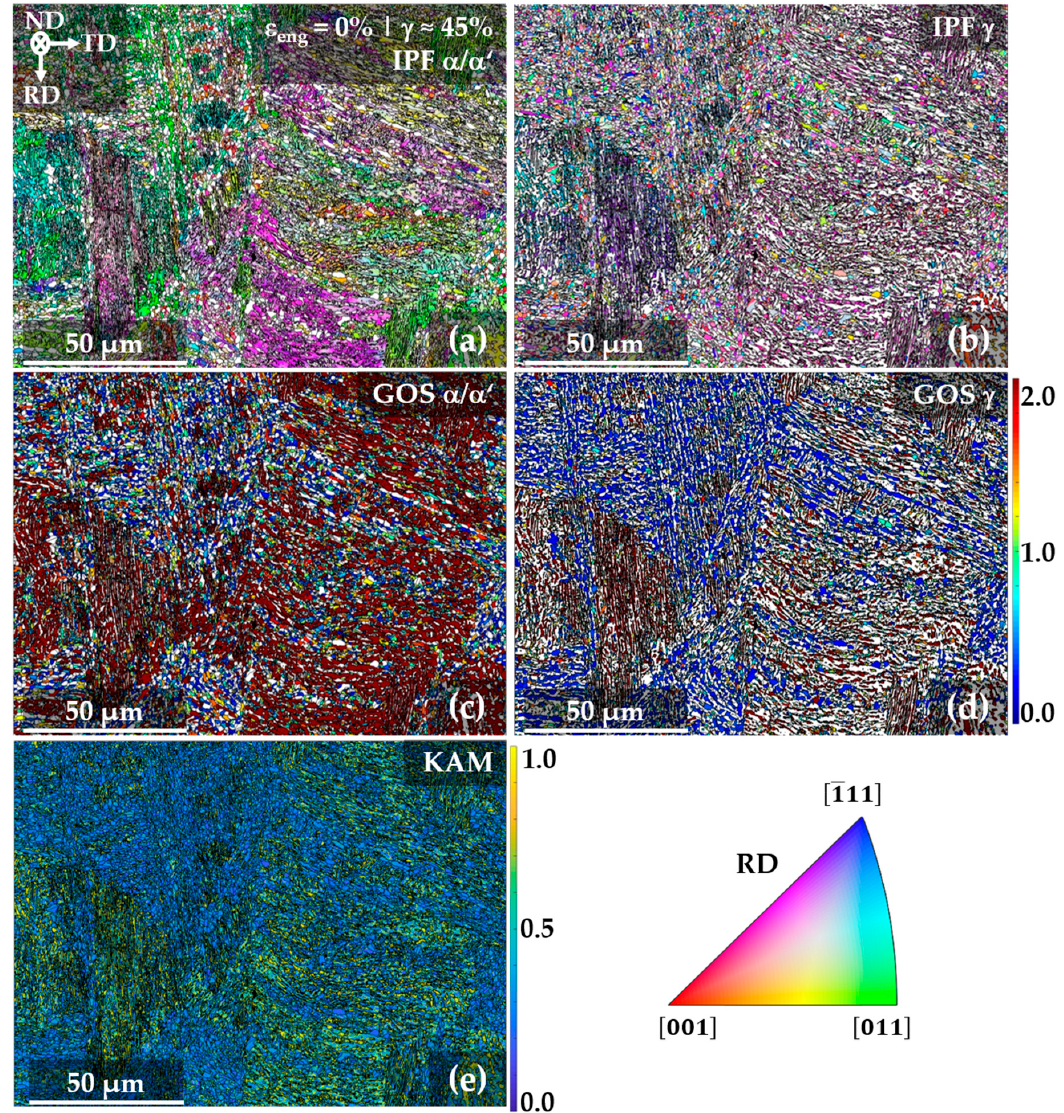
Figure 7. EBSD maps of the X6MnAl12-3 alloy prior to deformation ( a , b ) with inverse pole figure (IPF) color coding relative to the rolling direction (RD) for ( a ) α and α ’ and ( b ) γ . Grain orientation spread (GOS) maps for ( c ) α and α ’, ( d ) γ , and ( e ) the kernel average misorientation (KAM) map are shown. White areas in ( a – d ) correspond to ( a , c ) γ and ( b , d ) α or α ’, respectively.